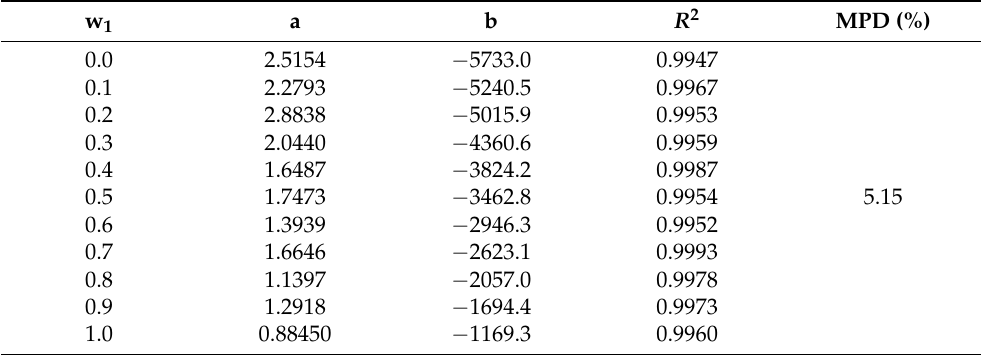
Table 3. Resulting data for “van’t Hoff model” for CNZ (3) in different {TP (1) + water (2)} combina- tions.